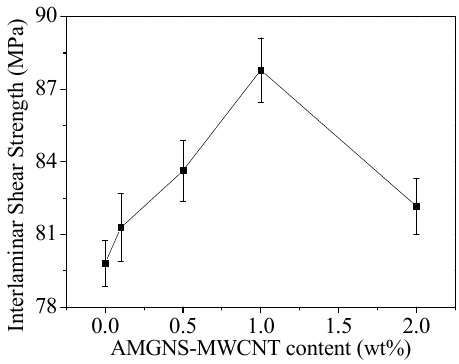
Figure 7. Interlaminar shear strength of the AMGNS-MWCNT/CFEP unidirectional composites.